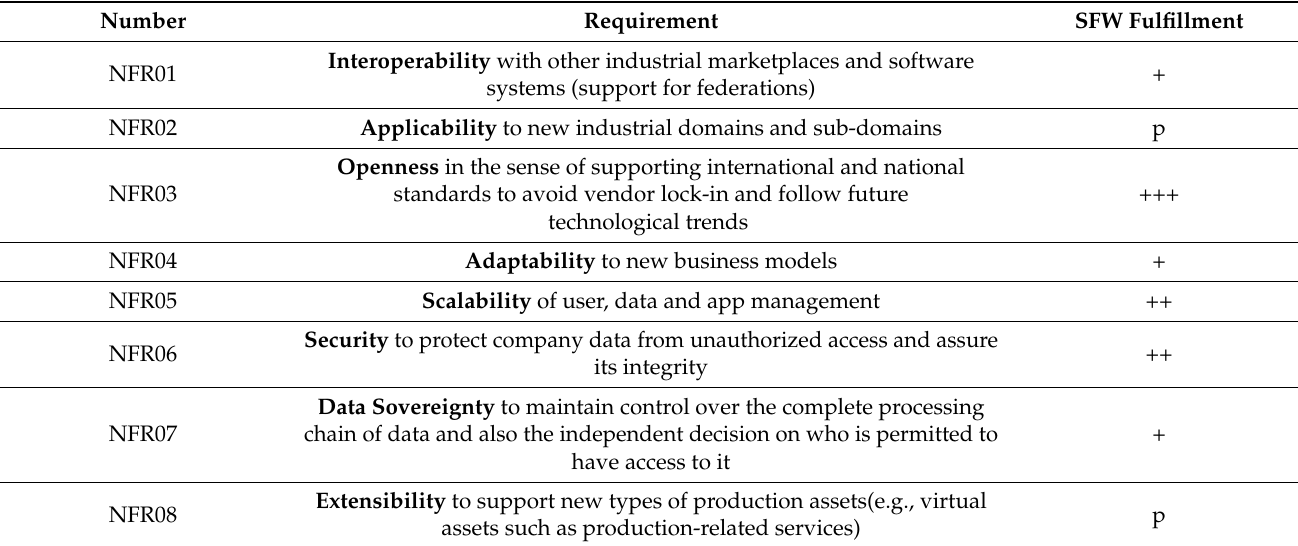
Table 7. Smart Factory Web in relation to the non-functional requirements in the platform economy.